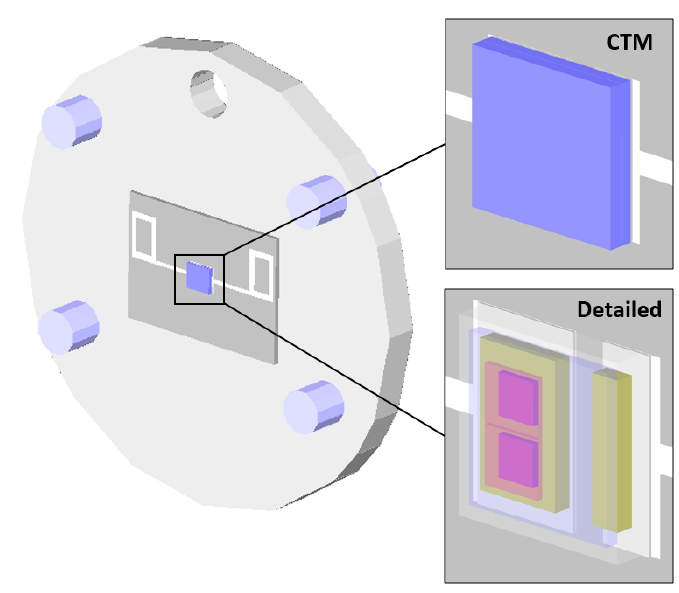
Figure 5. CTM validation configuration.